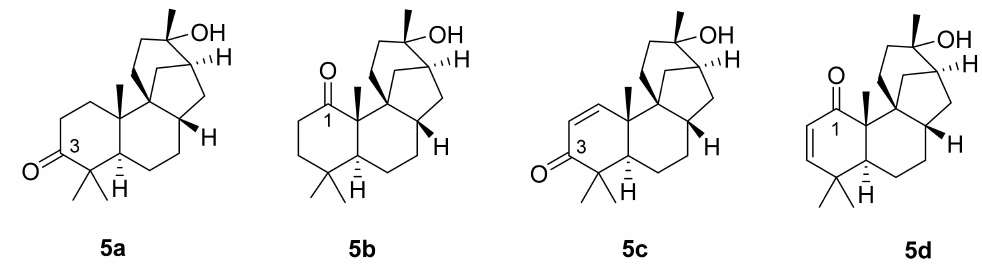
Figure 5. Chemical work for the establishment of (+)-maritimol ( 3 ) structure